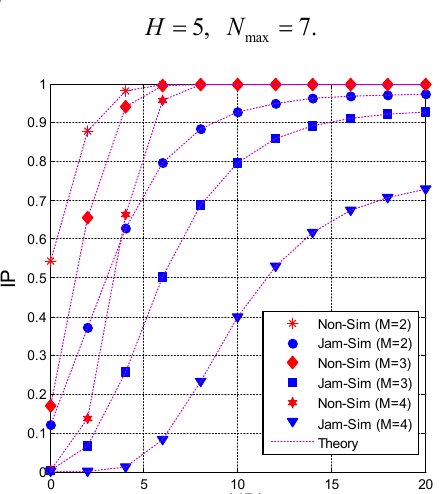
Figure 3 . IP as a function of D dB when 0.85, α=